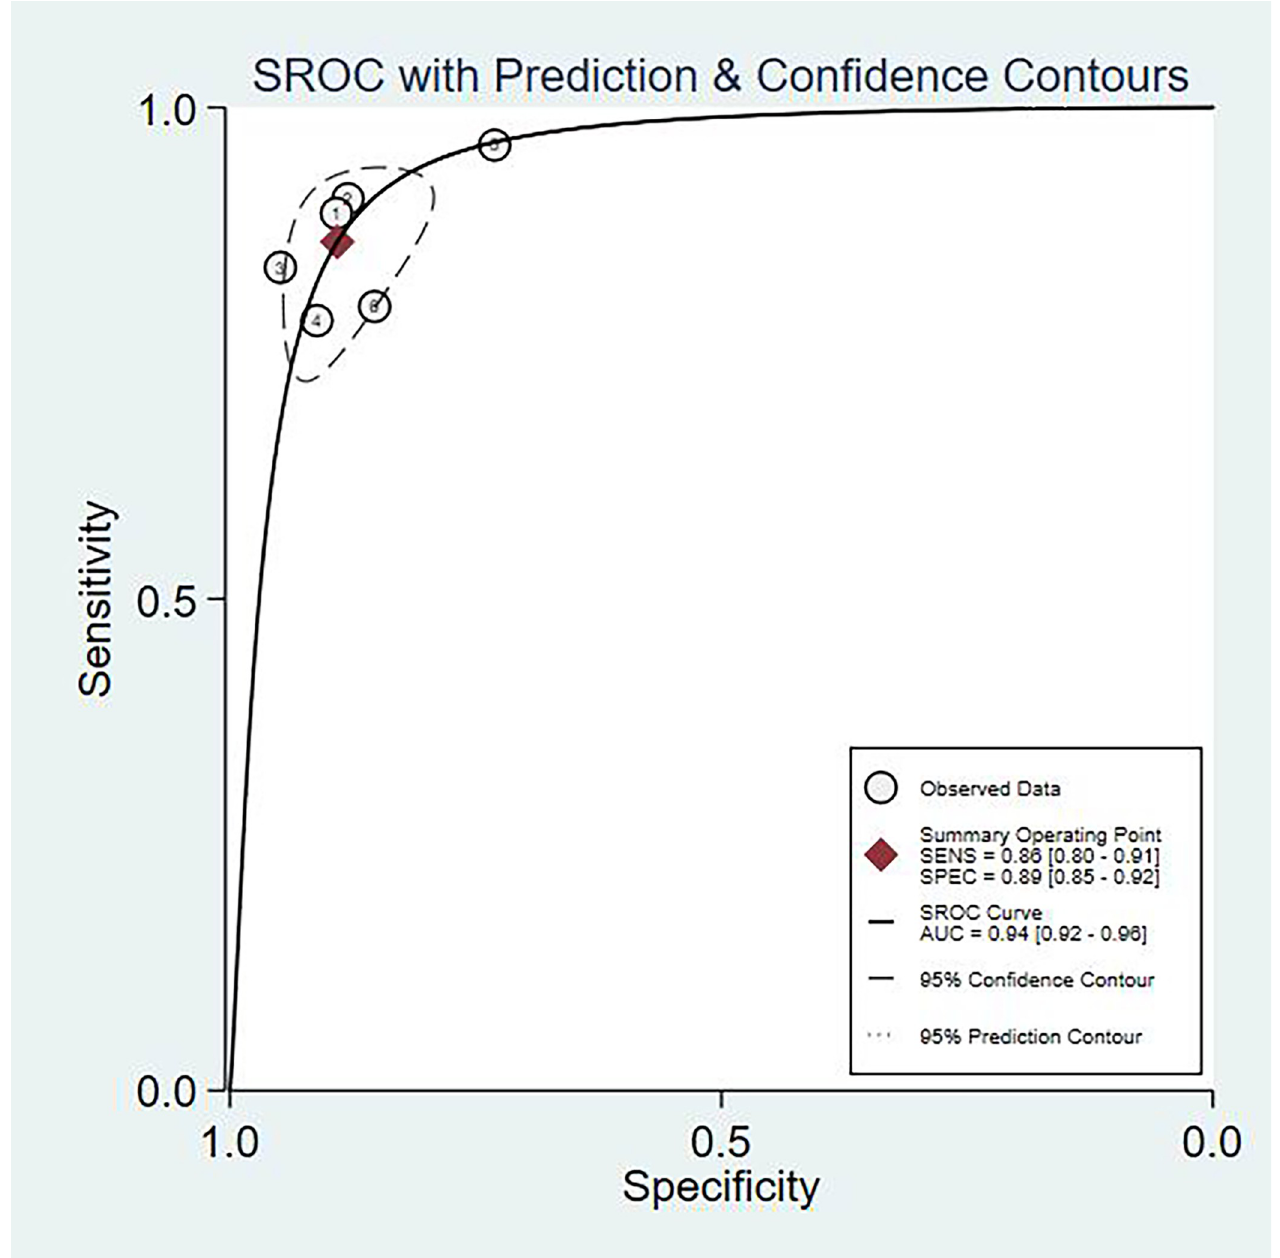
Fig 5. SROC curve for the accuracy of TI-RADS combined with SMI in the diagnosis of thyroid nodules. SROC summary receiver operator characteristic, AUC area under curve.